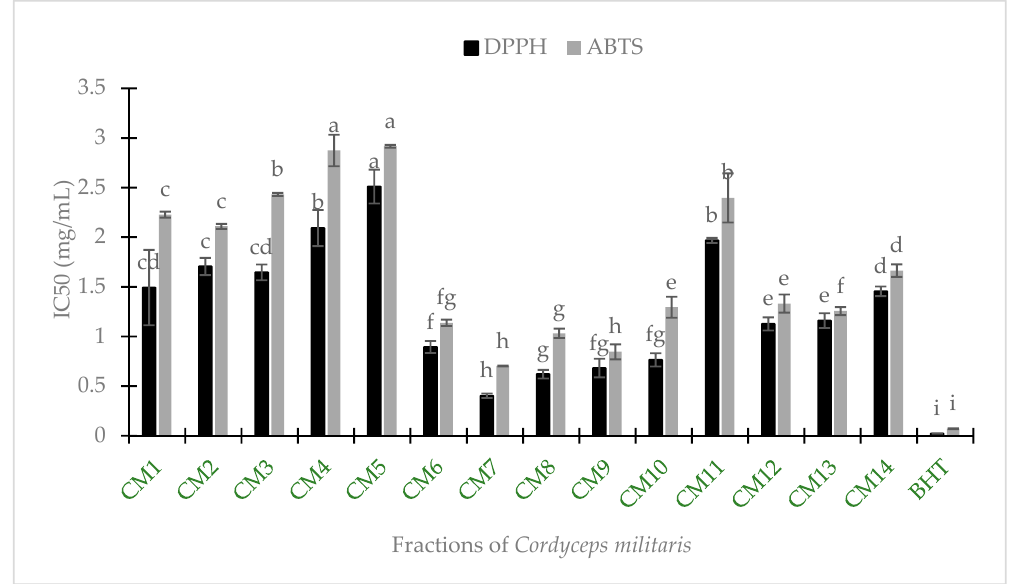
Figure 1. DPPH and ABTS radical scavenging activities of fractions from C. militaris and standard antioxidant butylated hydroxytoluene (BHT). Column with similar letters are not significantly different ( p < 0.05).